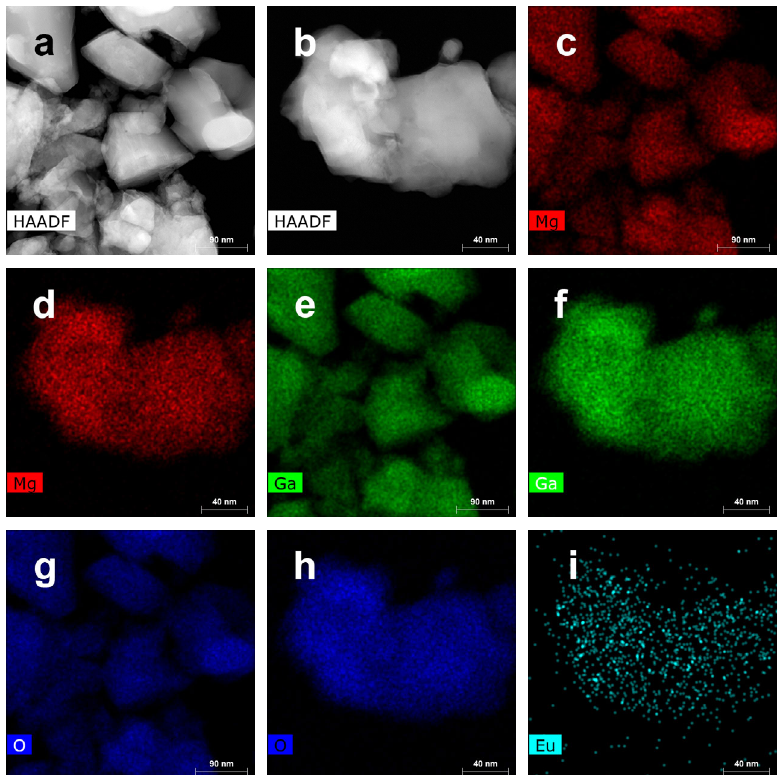
Fig. 2 HAADF  STEM images of (a) MgGa 2 O 4 :Mn 2+ and (b) MgGa 2 O 4 :Mn 2+ ,Eu 3+ grains, with corresponding chemical composition EDS maps of (c, e, g) MgGa 2 O 4 :Mn 2+ and (d, f, h, i) MgGa 2 O 4 :Mn 2+ ,Eu 3+ grains, representing location of each element in the grain.